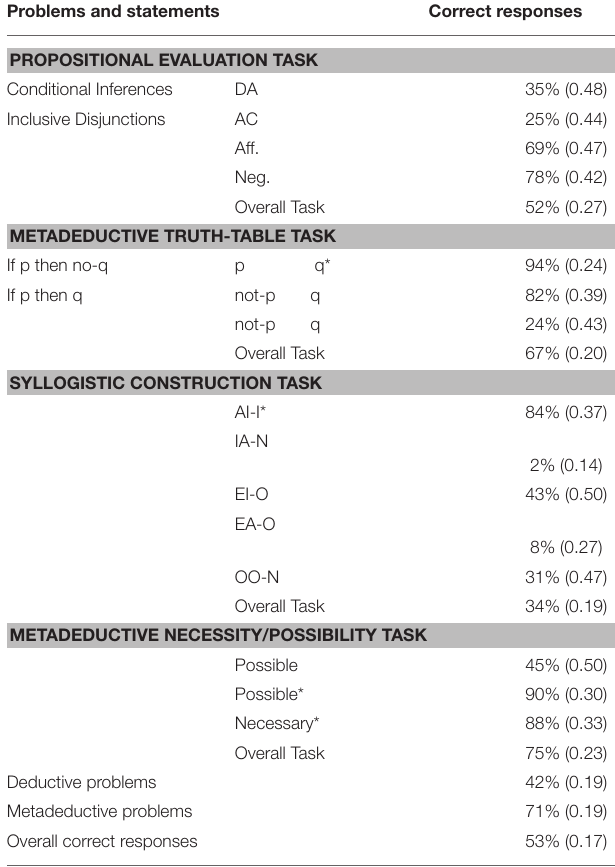
TABLE 2 | The percentages of correct responses (Standard deviation) for each of the problems in the Deductive Reasoning